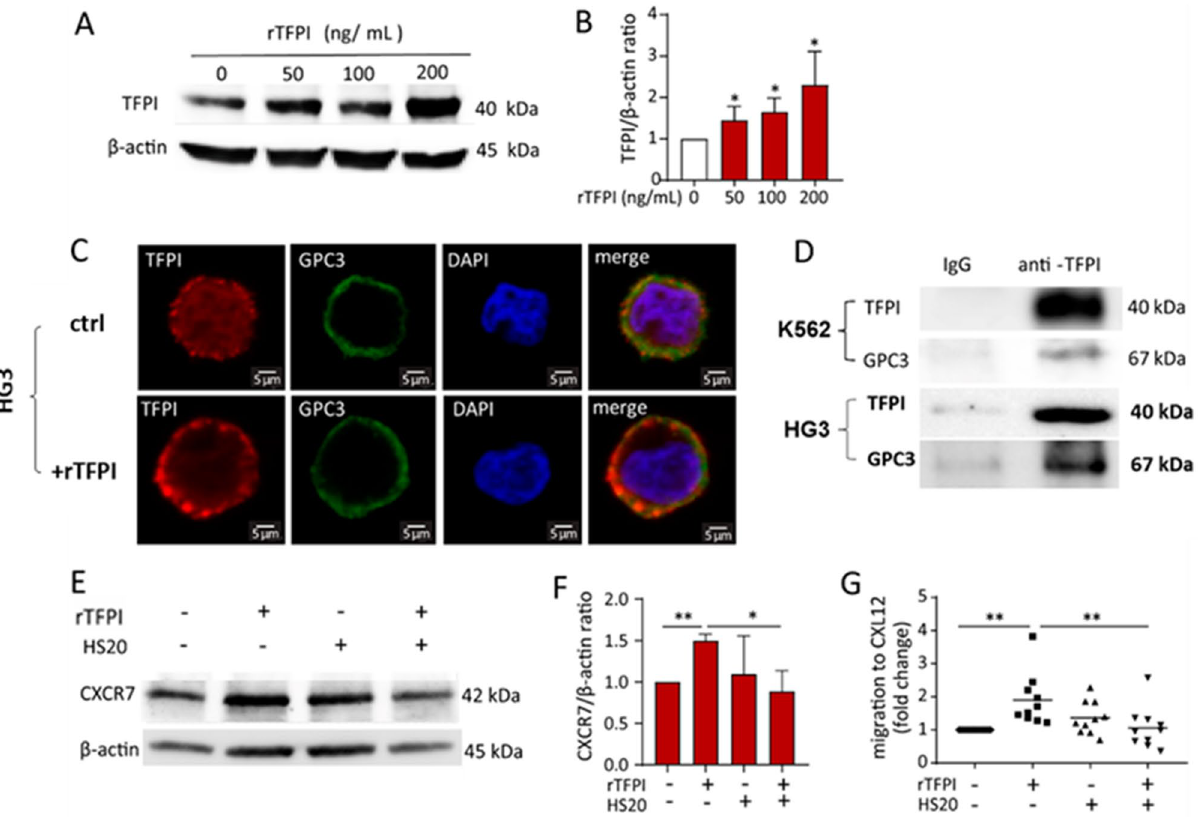
Figure 4. TFPI binds to GPC3 on the membrane of CLL cells. ( A ) Western blotting and ( B ) quantification of TFPI protein in the cell lysates of CLL patients, relative to β-actin, after 0, 50, 100 and 200 ng/mL rTFPI treatment. n = 3 individuals; *P < 0.05. ( C ) After 24 h treatment of 200 ng/mL rTFPI, co-localization of TFPI (red) and GPC3 (green) on the surface of human CLL cell line HG3 was assessed by immunofluorescence staining. Nuclei were stained with DAPI (blue). ( D ) Co-IP was performed in the HG3 and K562 cells. Immunoblots showed the bait protein TFPI and the pull-down of the prey protein GPC3. ( E ) Western blotting and ( F ) quantification of CXCR7 expression, relative to β-actin, after CLL cells were pre-treated with GPC3 antibody HS20 (100 µg/mL) for 1 h prior to 24 h treatment of 200 ng/mL rTFPI. Human IgG was used as control since HS20 is isolated from human serum. n = 4 individuals; *P < 0.05, **P < 0.01. ( G ) After CLL cells were pre-treated with HS20 before rTFPI treatment, the cells were washed and applied to TEM assay. Human IgG was used as control. Results were presented as we described in Fig. 2A. n = 10 individuals; **P <